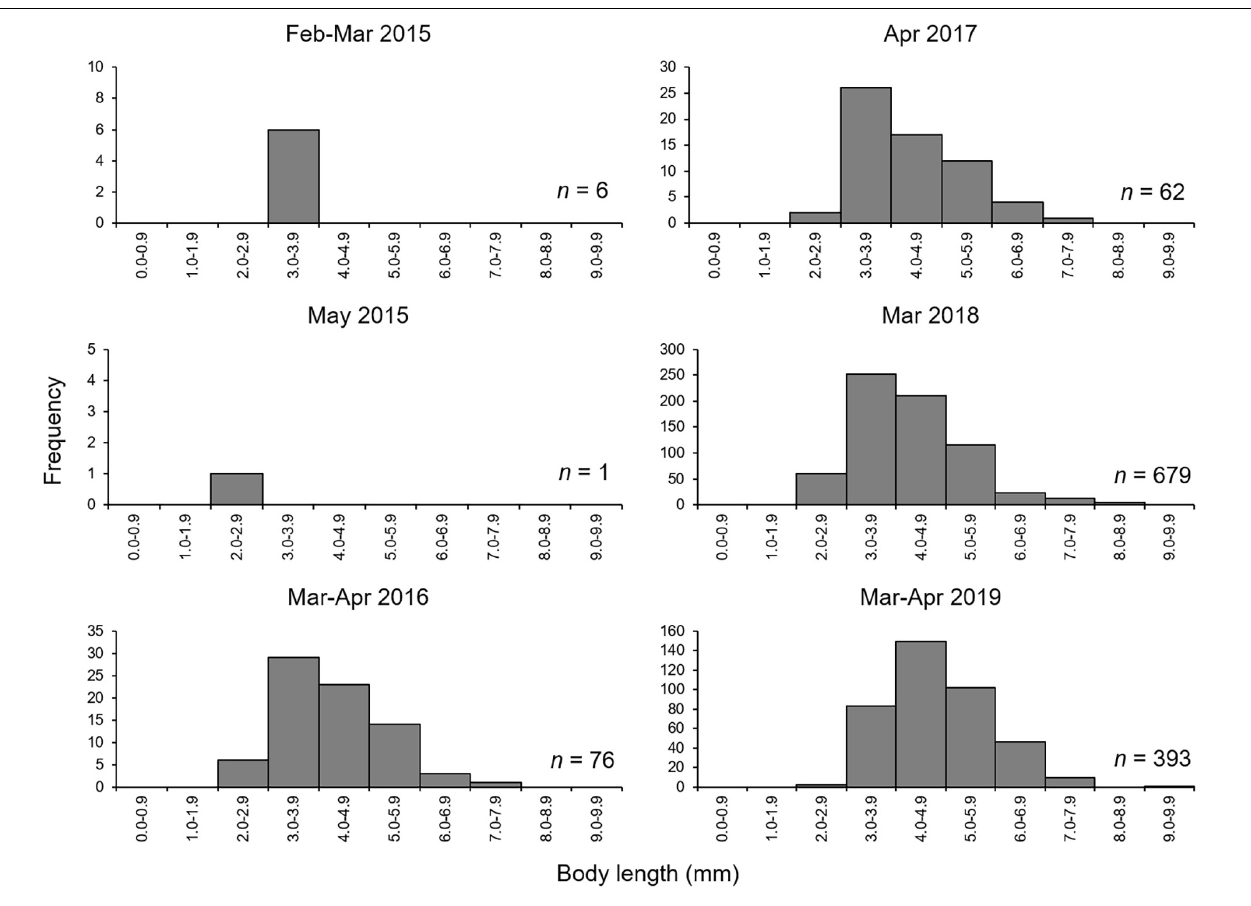
FIGURE 4 | Body length compositions of Scomber spp. larvae from 2015 to